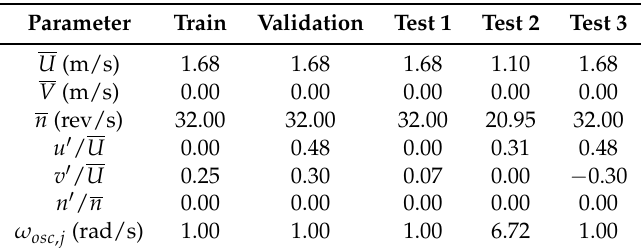
Table 2. Behind condition parameters for unsteady